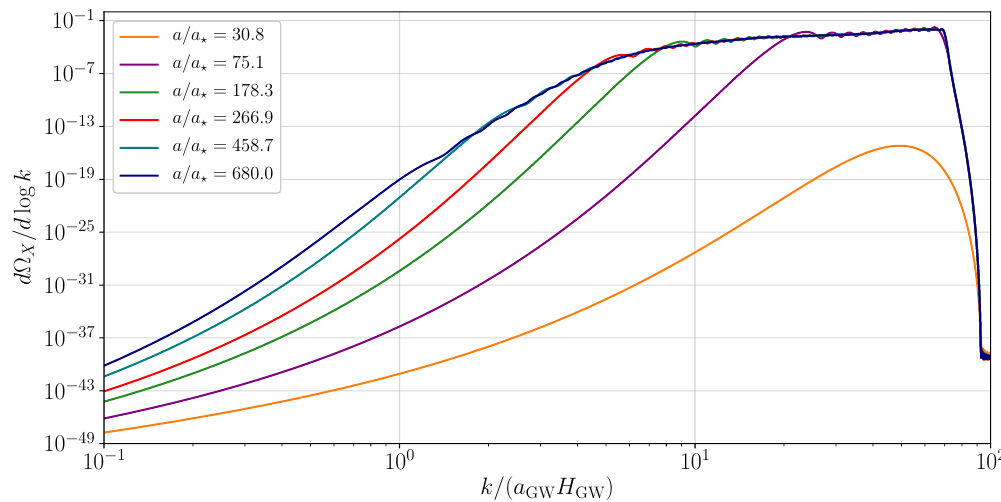
Figure 3: Evolution of the dark photon spectrum for the same simulation as in Fig.